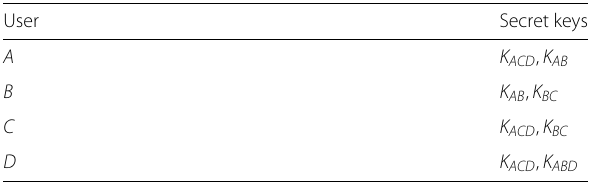
Table 2 Secret keys with each user